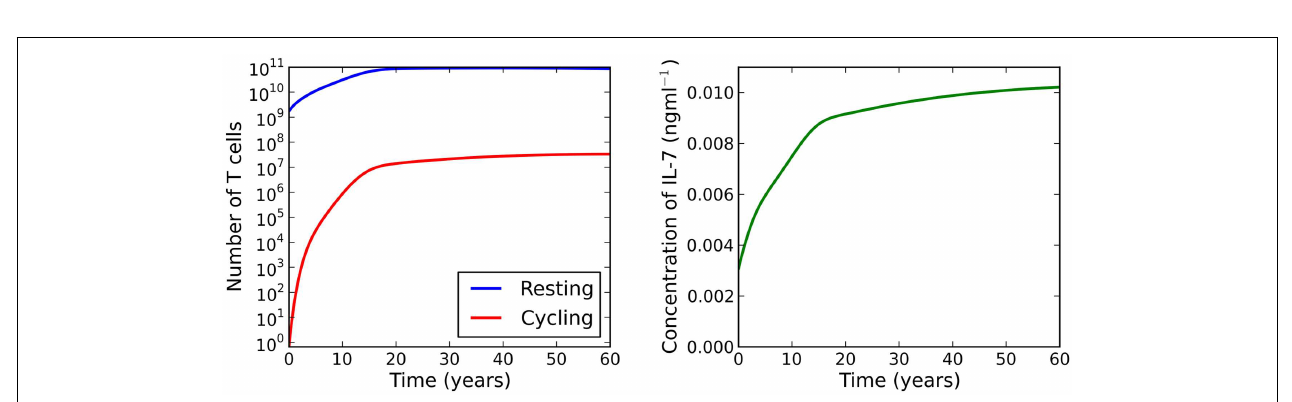
FIGURE 5 | Numerical solutions to equations (13–15) for λ>µ C . Initial conditions are chosen to be the adiabatic solutions of equations (16–18) at t = 0.We observe a large increase in the naiveT cell population from birth to